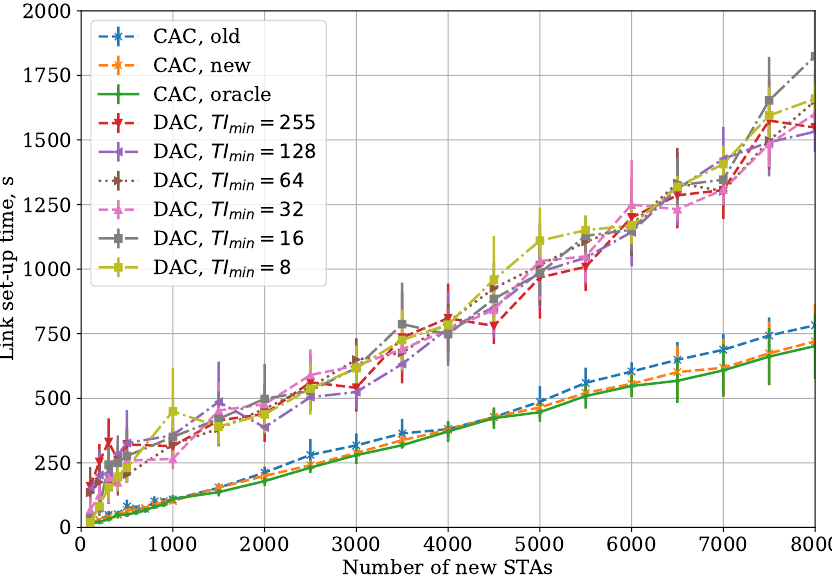
Figure 7. CAC and DAC protocols: dependency of link set-up time on the number of new STAs for the Large Area